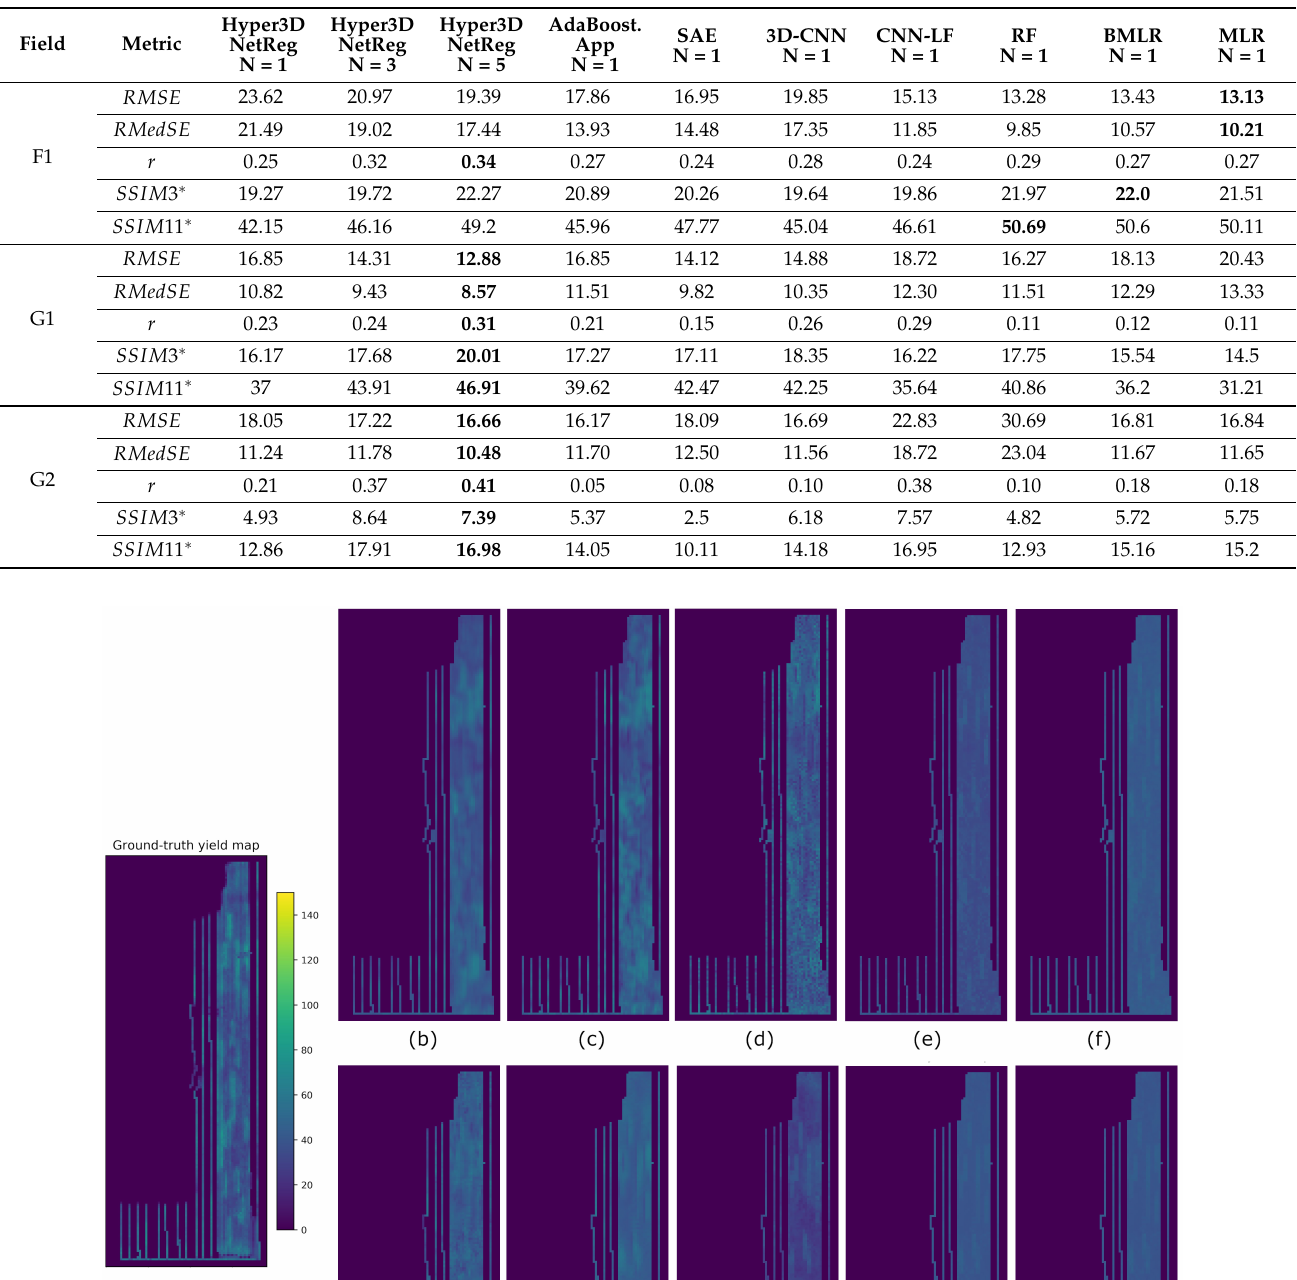
Table 6. Yield prediction comparison (split C). Best-performing metrics are highlighted in bold. SSIM 3 ∗ and SSIM 11 ∗ are SSIM values multiplied by 100.